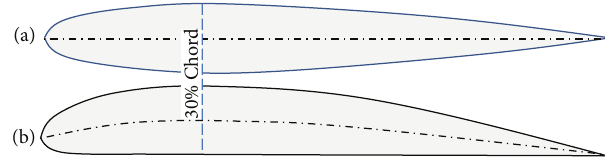
Figure 7: The NACA 0012 (symmetric) foil (a) the N22 cambered foil (b). Table 3: Lift and drag coefficients for three angles of attack (Rn = 1.3𝐸5